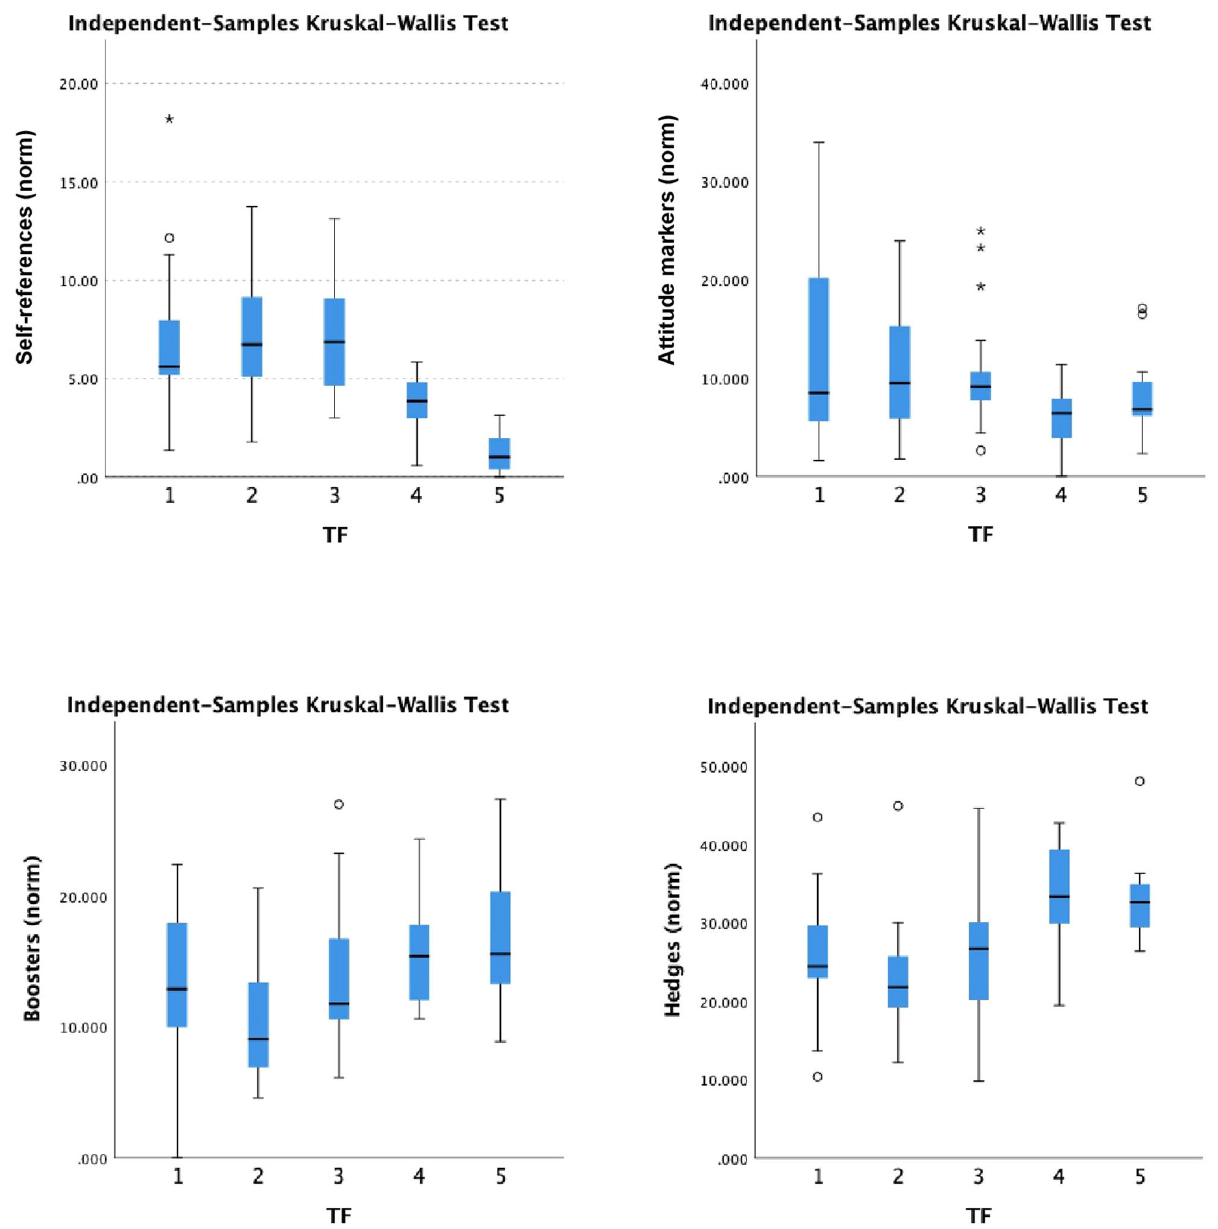
Fig. 4 Boxplots of marker frequencies per 1000 words in each timeframe. Outliers are identi fi ed using small circles to denote ‘ out ’ values and stars to denote ‘ far out ’ values (referred to as ‘ extreme values ’ in